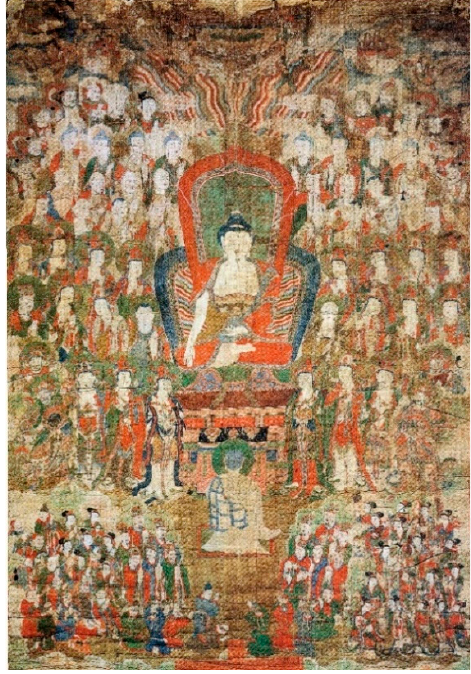
Figure 4. Sakyamuni Preaching , Joseon (1653), Color on hemp, 813 x 554 cm, Yeongsusa Temple (Tongdosa Museum 2008, p. 1).